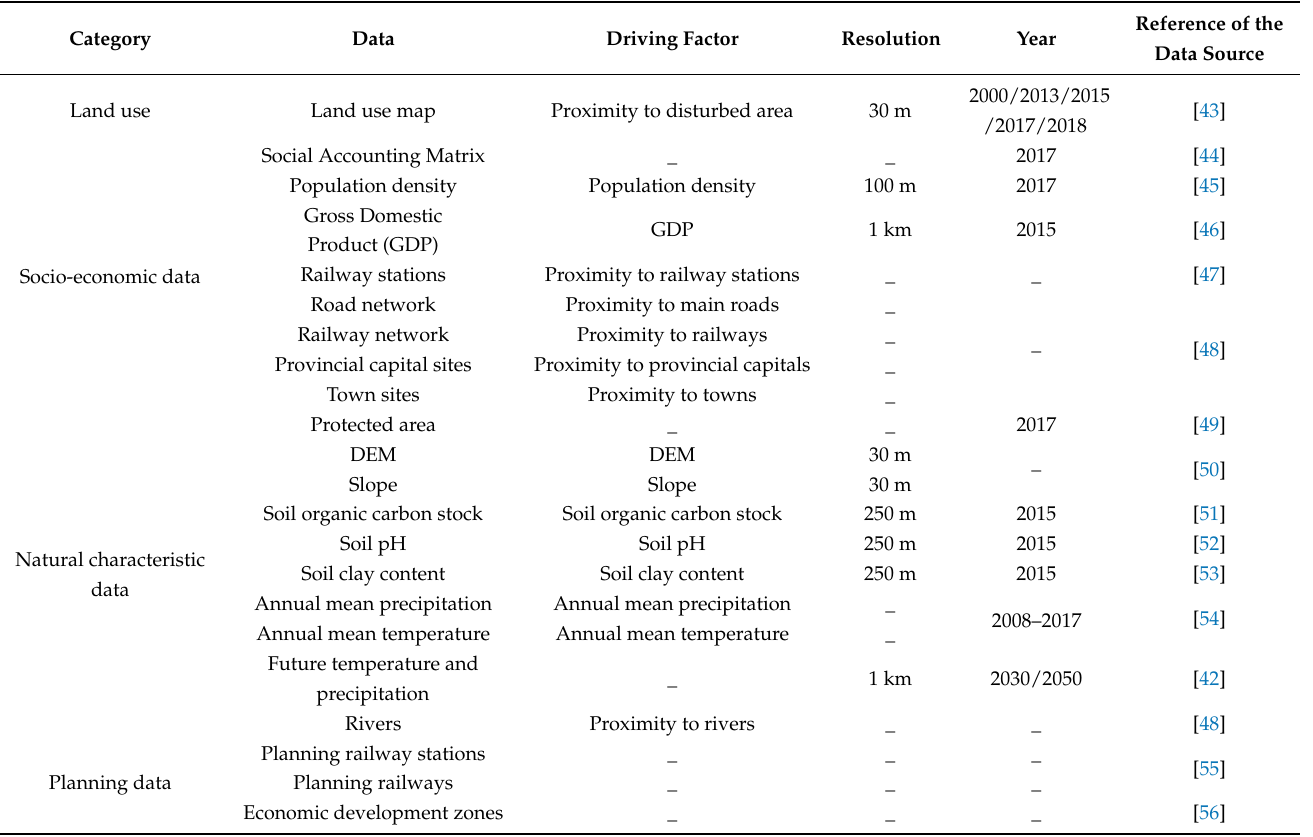
Table 1. Main information of the input data in this